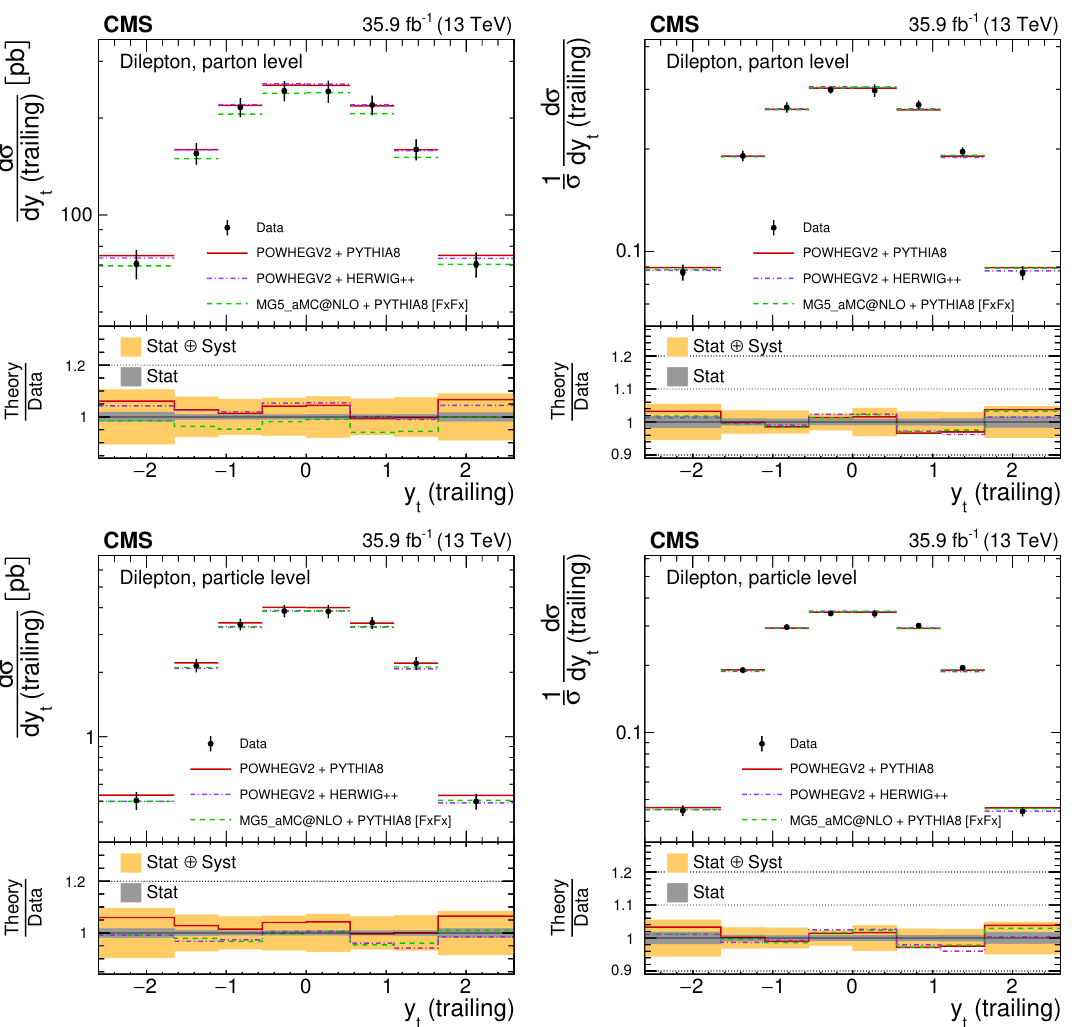
Figure 19 . The di(cid:11)erential tt production cross sections as a function of y t (trailing) are shown for the data (points) and the MC predictions (lines). The vertical lines on the points indicate the total uncertainty in the data. The left and right columns correspond to absolute and normalised measurements, respectively. The upper row corresponds to measurements at the parton level in the full phase space and the lower row to the particle level in a (cid:12)ducial phase space. The lower panel in each plot shows the ratios of the theoretical predictions to the data. The dark and light bands show the relative statistical and total uncertainties in the data, respectively.